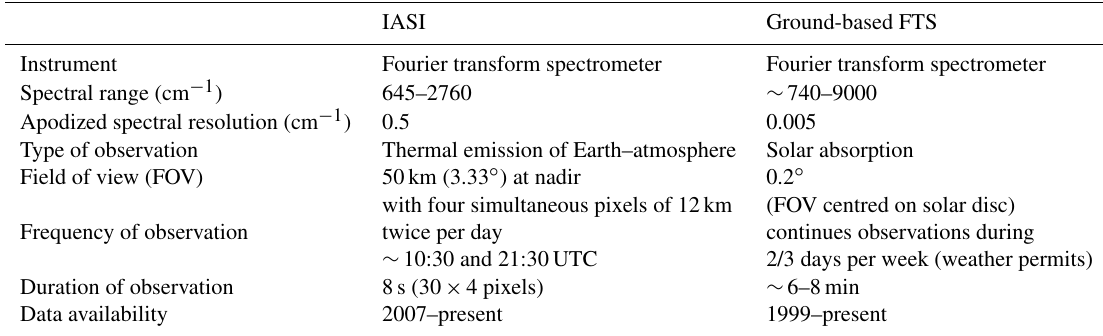
Table 1. Technical specifications of the IASI and IZO ground-based FTS instrument. IASI Ground-based FTS